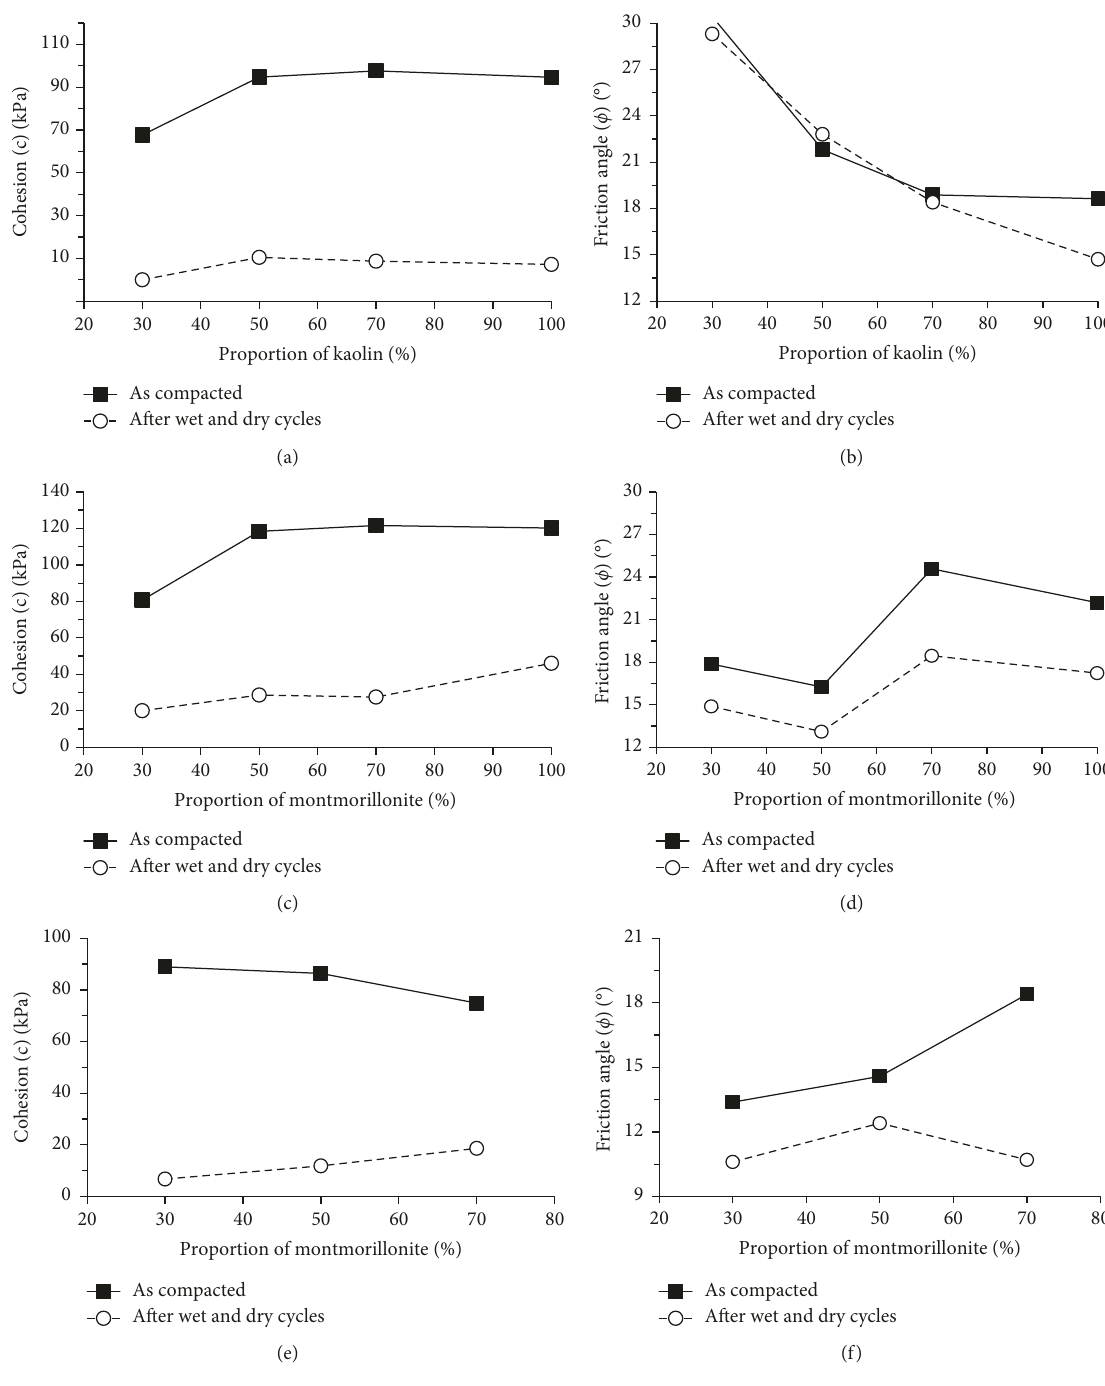
Figure 6: Comparison of shear strength characteristics between the as-compacted specimen and specimen subjected to wetting and drying: (a, b) kaolin-quartz mixtures; (c, d) montmorillonite-quartz; (e, f) montmorillonite-kaolin